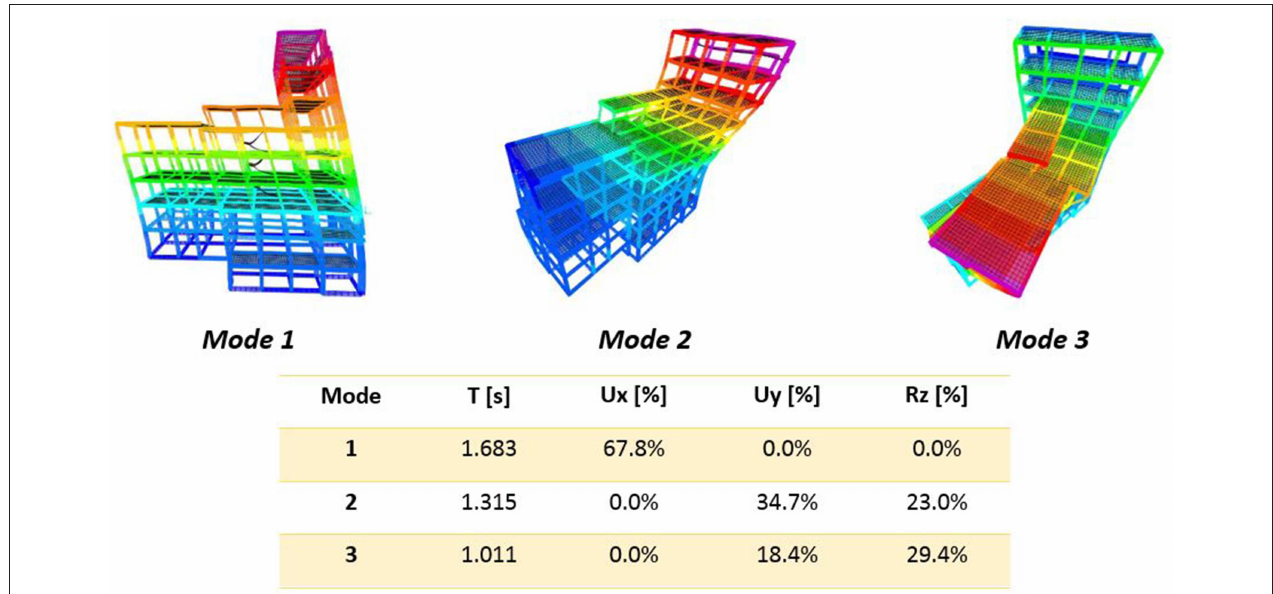
FIGURE 6 | Fixed-base model. Shapes and dynamic properties of the first three vibration